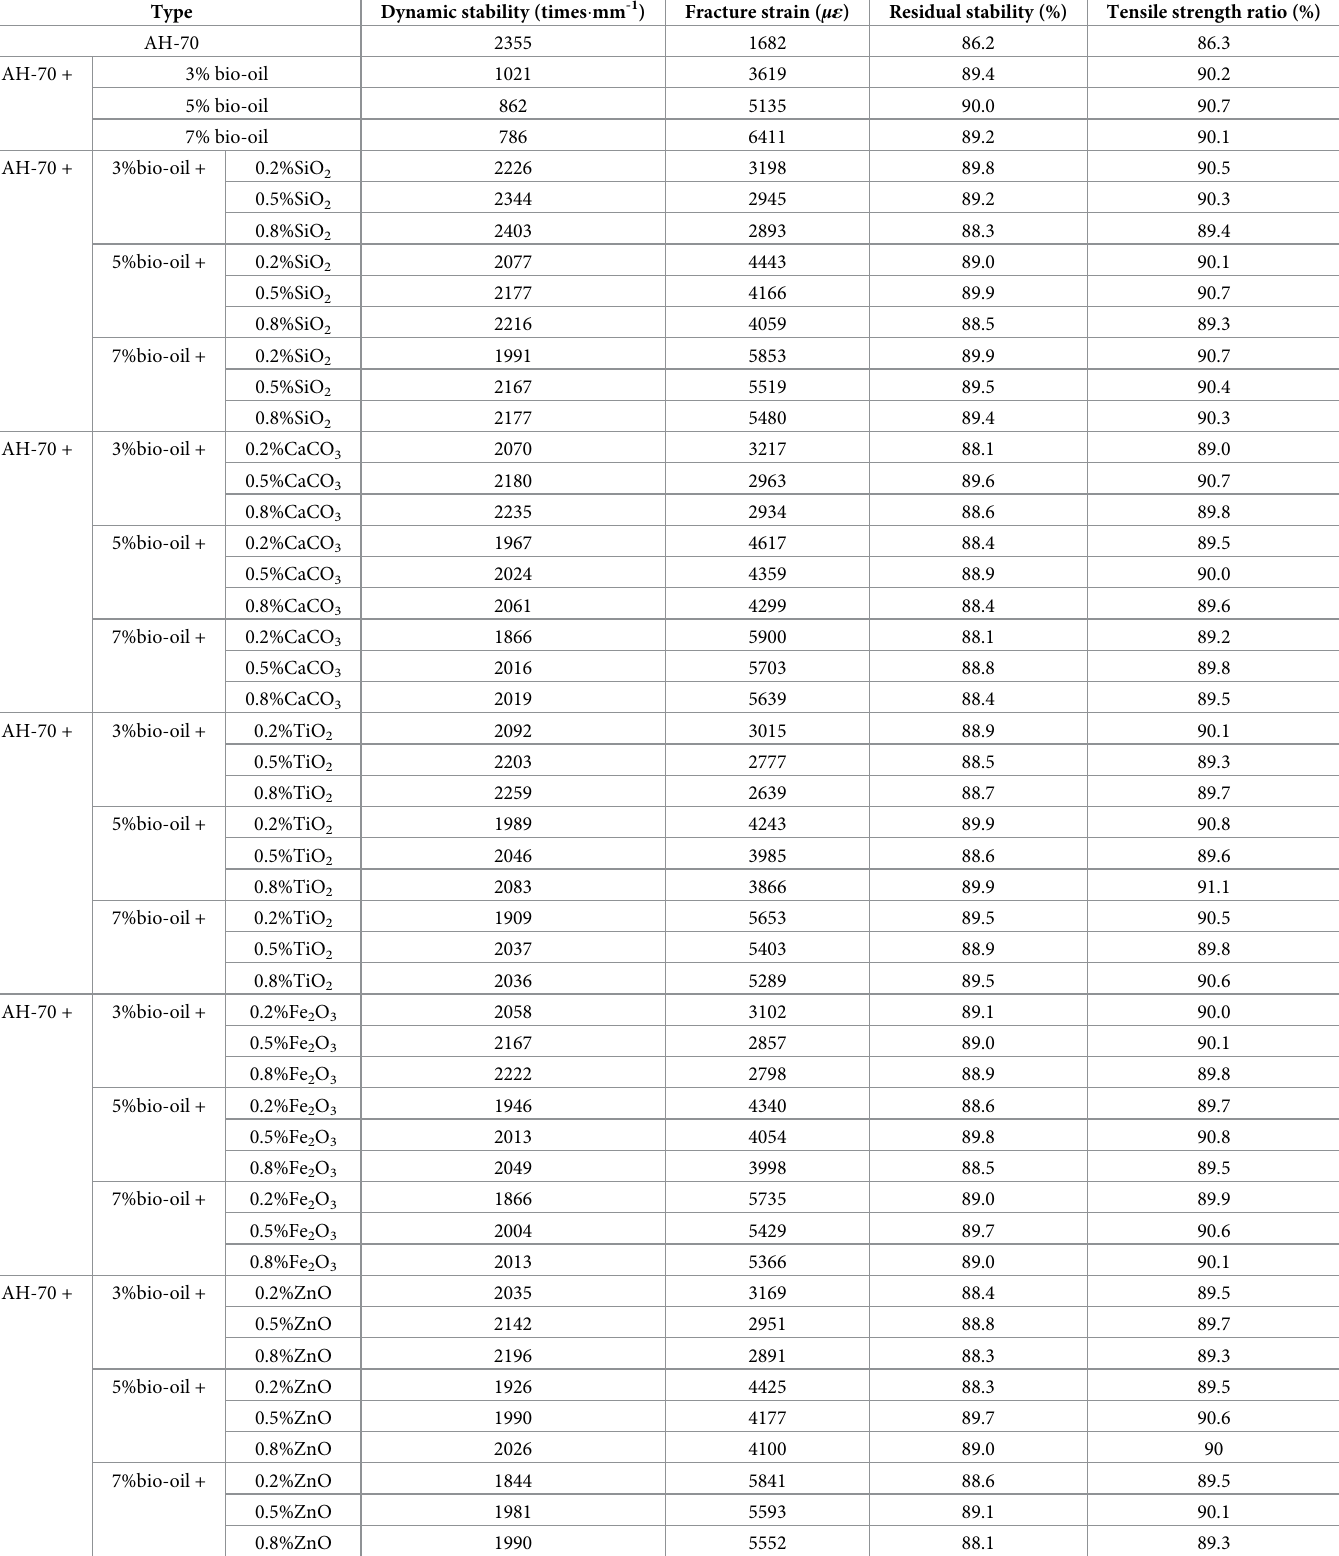
Table 8. Pavement properties of different asphalt